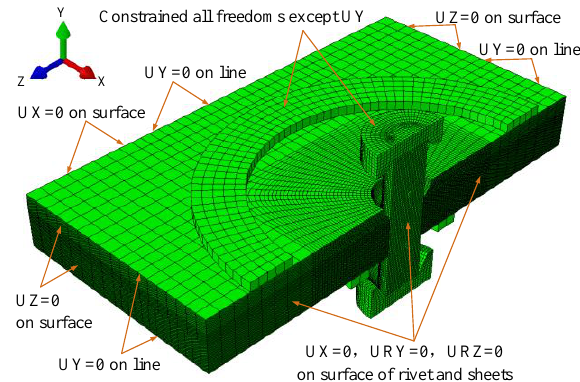
Figure 3. The FE model with mesh and boundary conditions.